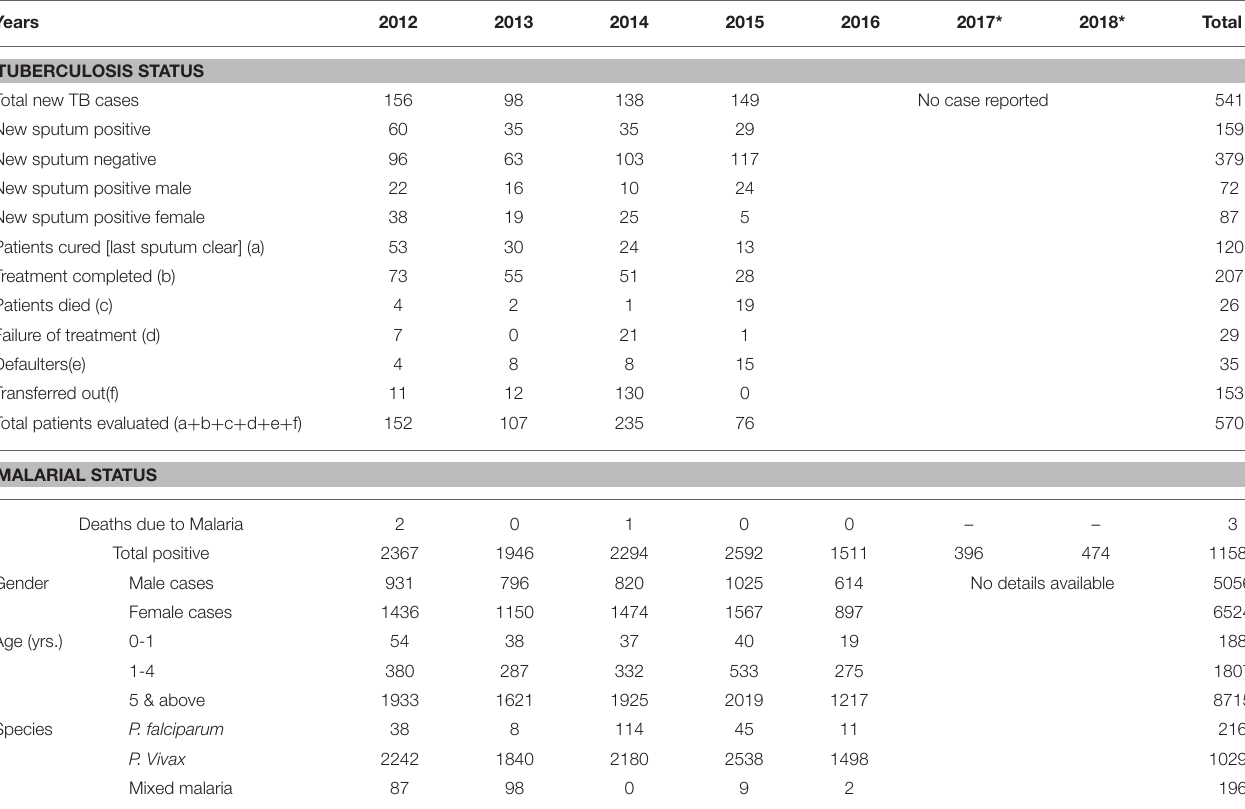
TABLE 4 | Tuberculosis and malarial status among Afghan